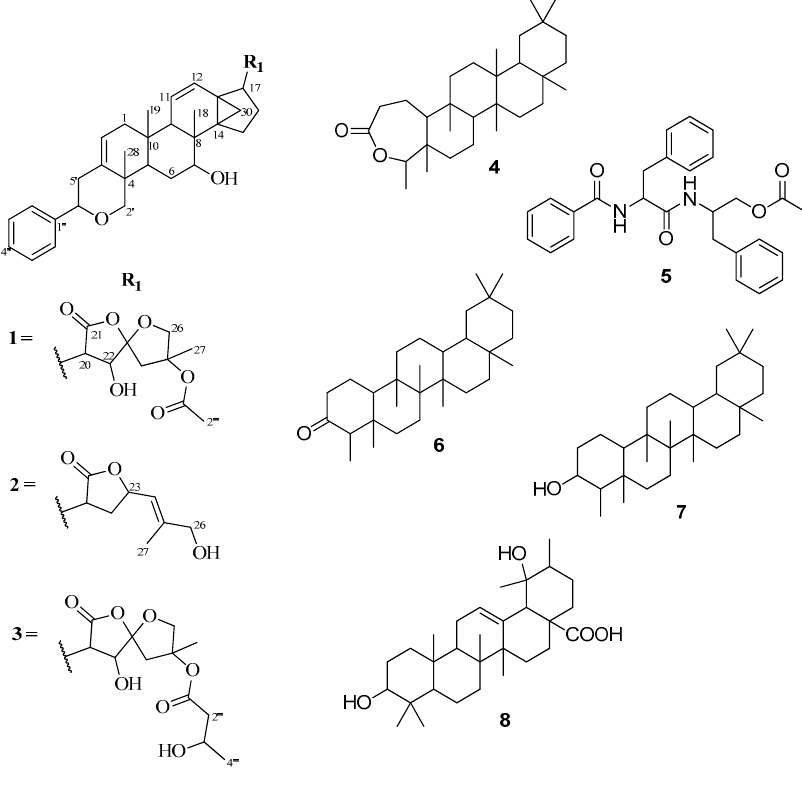
Figure 1. Structures of compounds 1 – 8 .